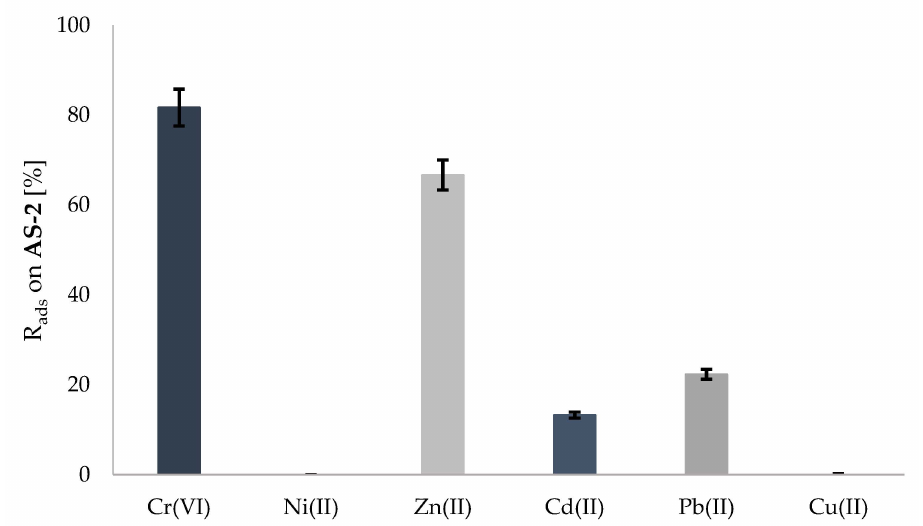
Figure 3. Sorption of metal ions on the active substrate ( AS-2 ) according to experiment